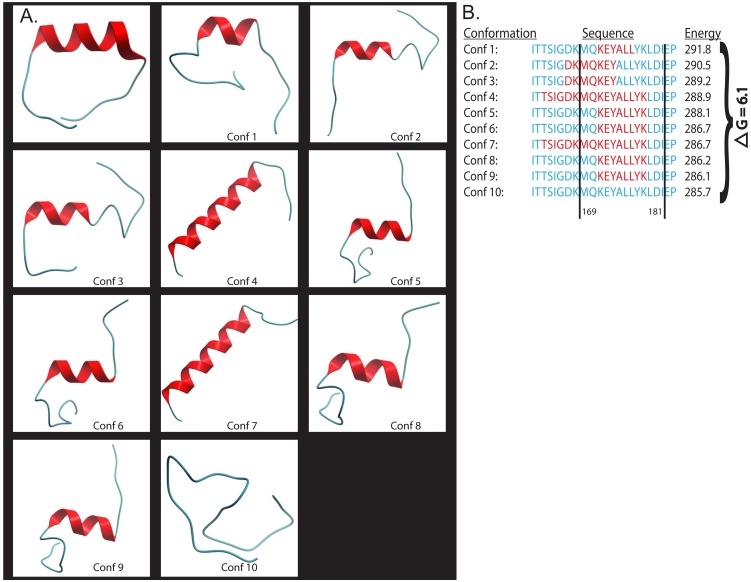
Computational folding of HIV V2 MN peptide shows a preference for the alpha-helical secondary structure.(A). Shows the lowest energy conformation of the ab-initio folding (top left) and the top ten conformations of the NMR-restrained ICM folding. Segments of the peptide that adopt alpha-helical structure are depicted in red. (B). Sequence alignment of the top ten NMR-restrained folding conformations with their corresponding energy scores. Red color indicates segments of the peptide that have adopted an α–helical conformation.